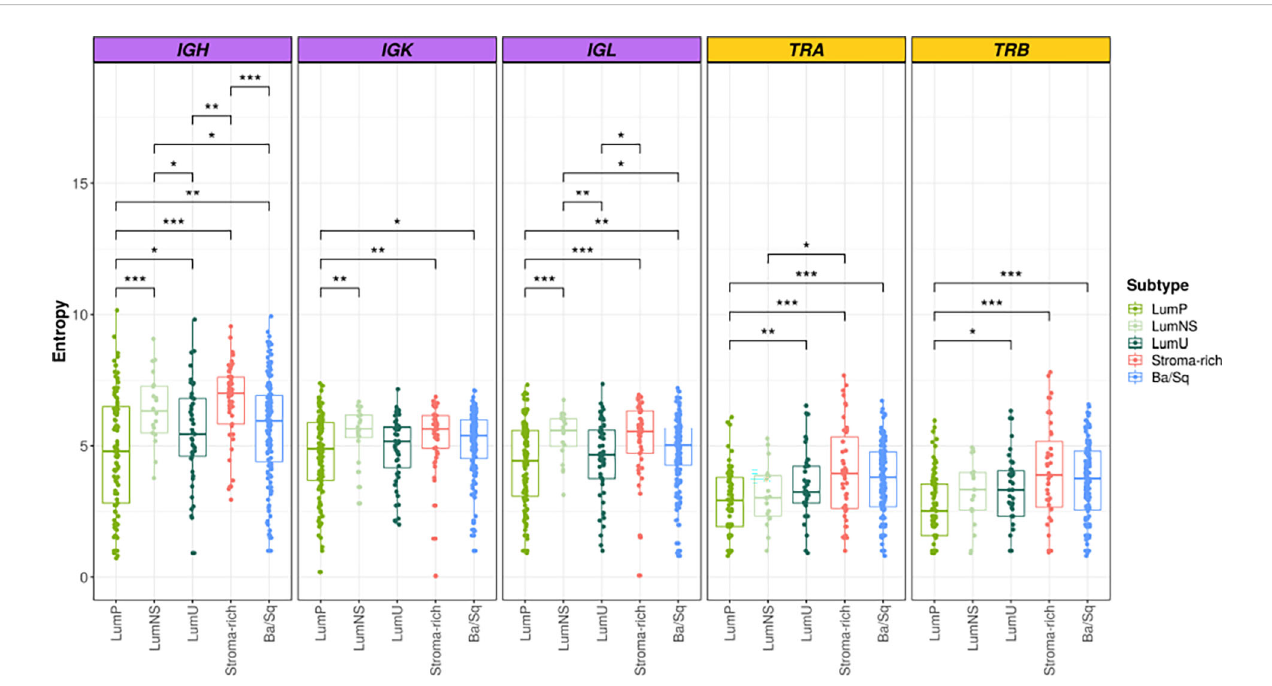
FIGURE 2 BCR and TCR diversity among the different MIBC subtypes. BCR related results are plotted in purple and TCR in yellow. In the Y axis entropy is represented. Each box of the boxplots is a subtype (see legend). The differences between diversity across the subtypes are displayed only when signi fi cant. Wilcoxon test: * → 0.05 > p > 0.01; ** → 0.01 > p > 0.001; *** → p <